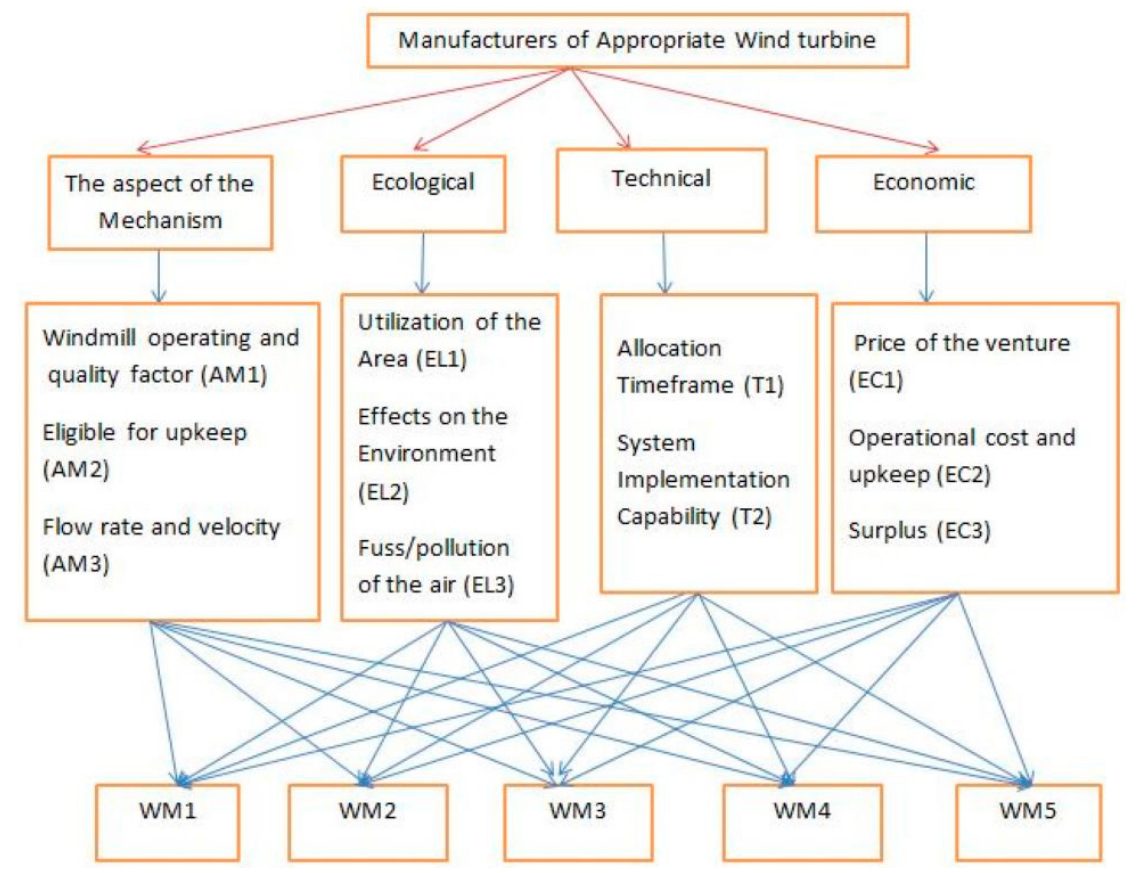
Figure 2. Criteria hierarchies, sub-criteria, and generator sources.